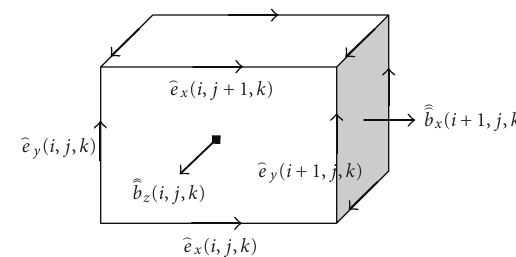
Figure 2: Electric voltages and magnetic flux allocations on a cell V i , j , k